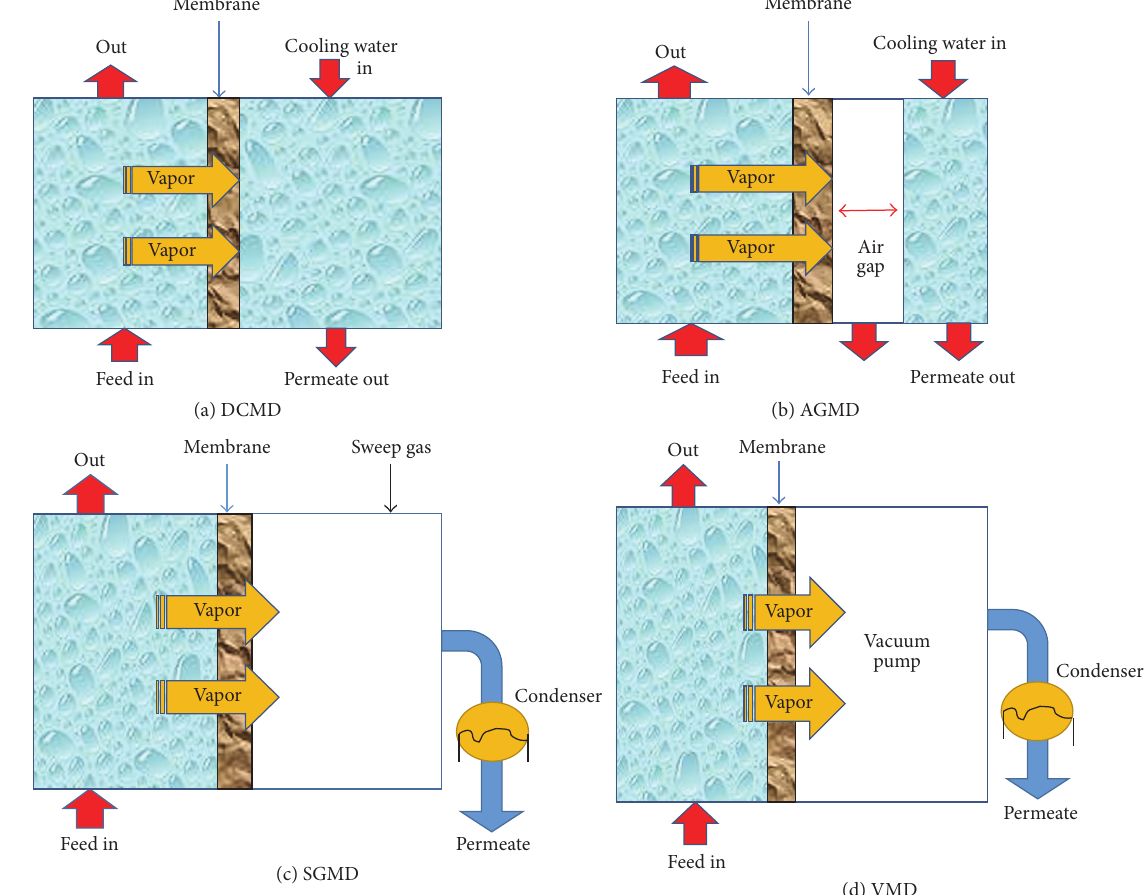
Figure 2: The membrane distillation configurations.